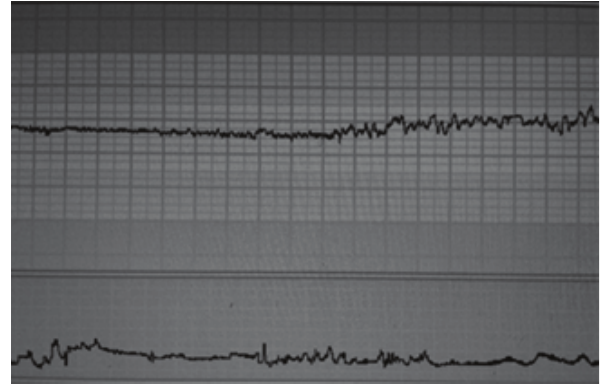
Figure 3: CTG of a fetus at 34 weeks of gestation: note baseline heart rate within the normal range, normal baseline variability with “cycling”.